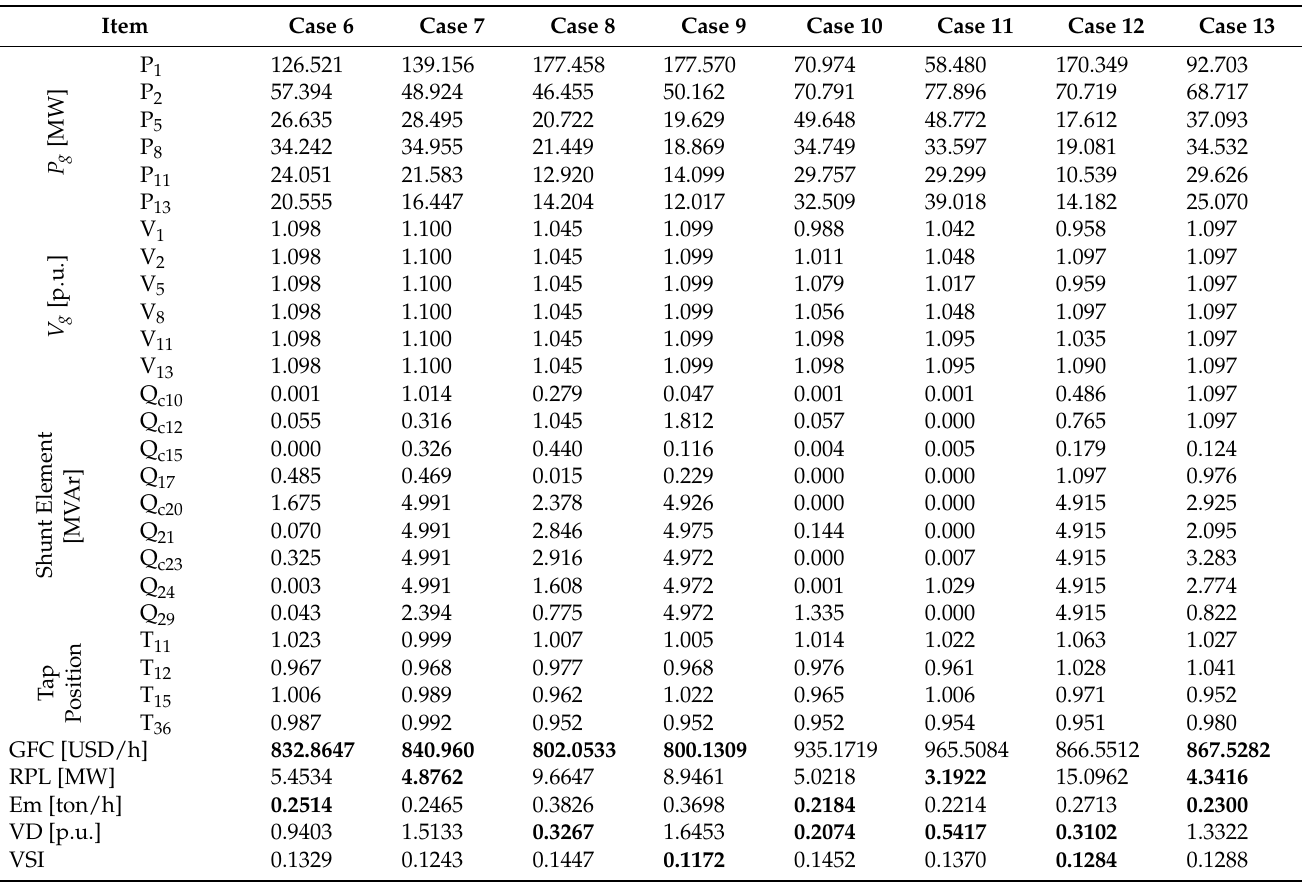
Table 6. Optimal control variables obtained by MOSMA for Cases